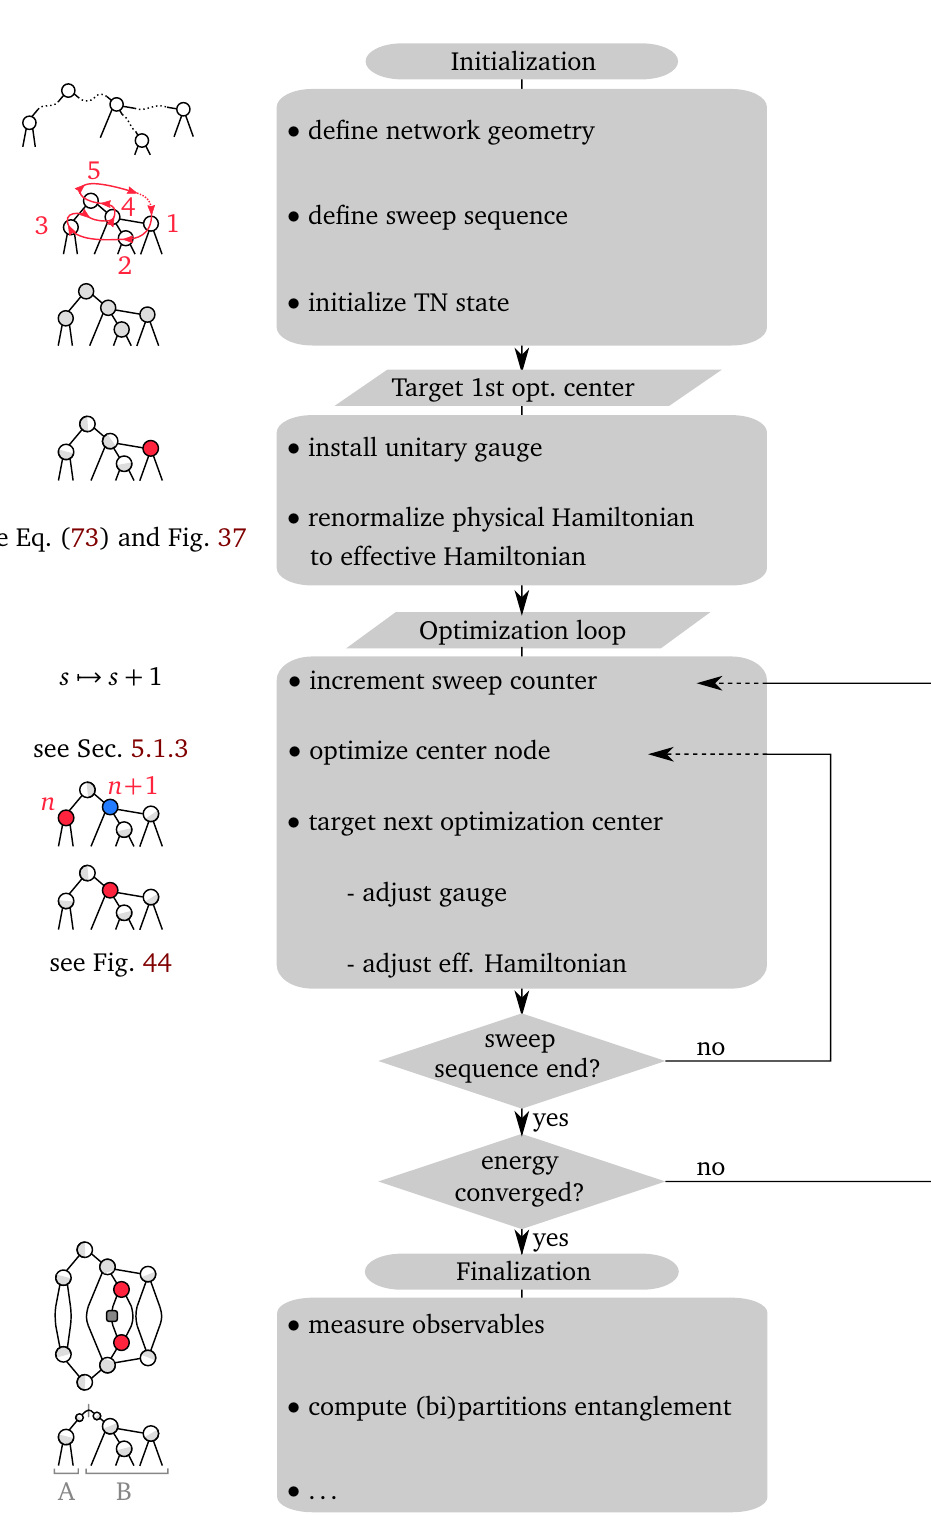
Figure 42: Flowchart of the GS algorithm. The left column provides illustra- tions / references for the corresponding items in the bullet